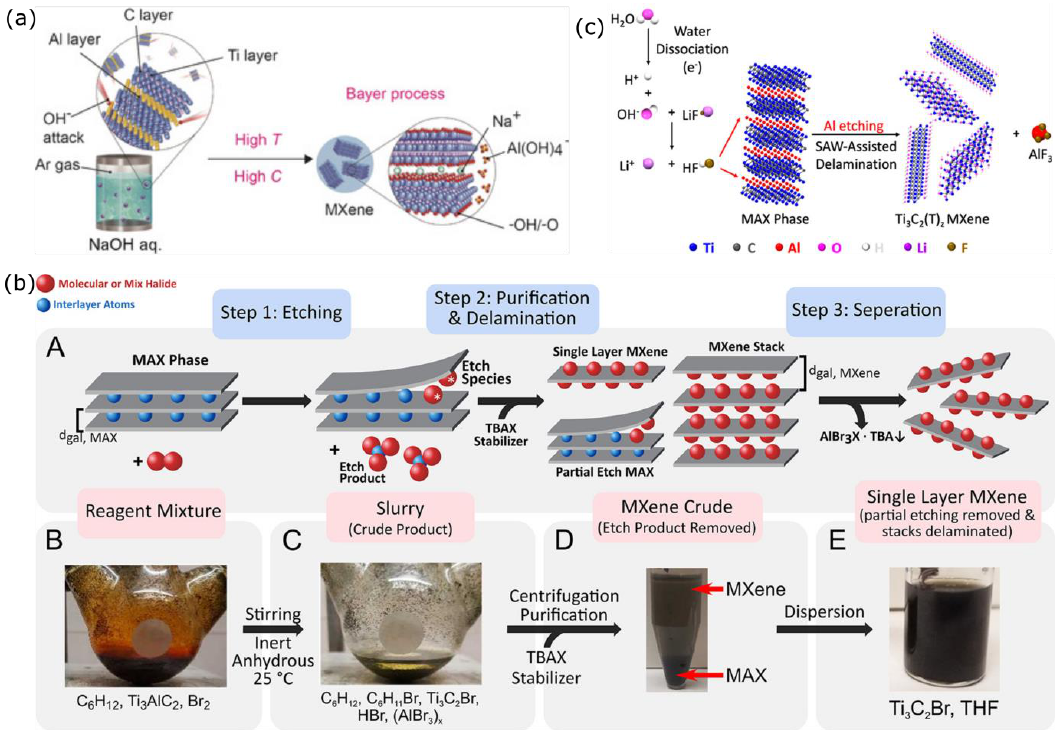
Figure 5. ( a ) According to the Bayer method, high temperatures synthesis and high NaOH concentrations support the dissolution of the Al (oxide) hydroxides in NaOH [76]. ( b ) The process for the formation of delaminated halogen-terminated MXenes; (A) adding Br 2 to Ti 3 AlC 2 in anhydrous cyclohexane generates a deep red solution; (B) Br 2 reacts with the Al interlayer inducing the supernatant thus turns to a pale yellow color, indicating a depletion of Br 2 and the